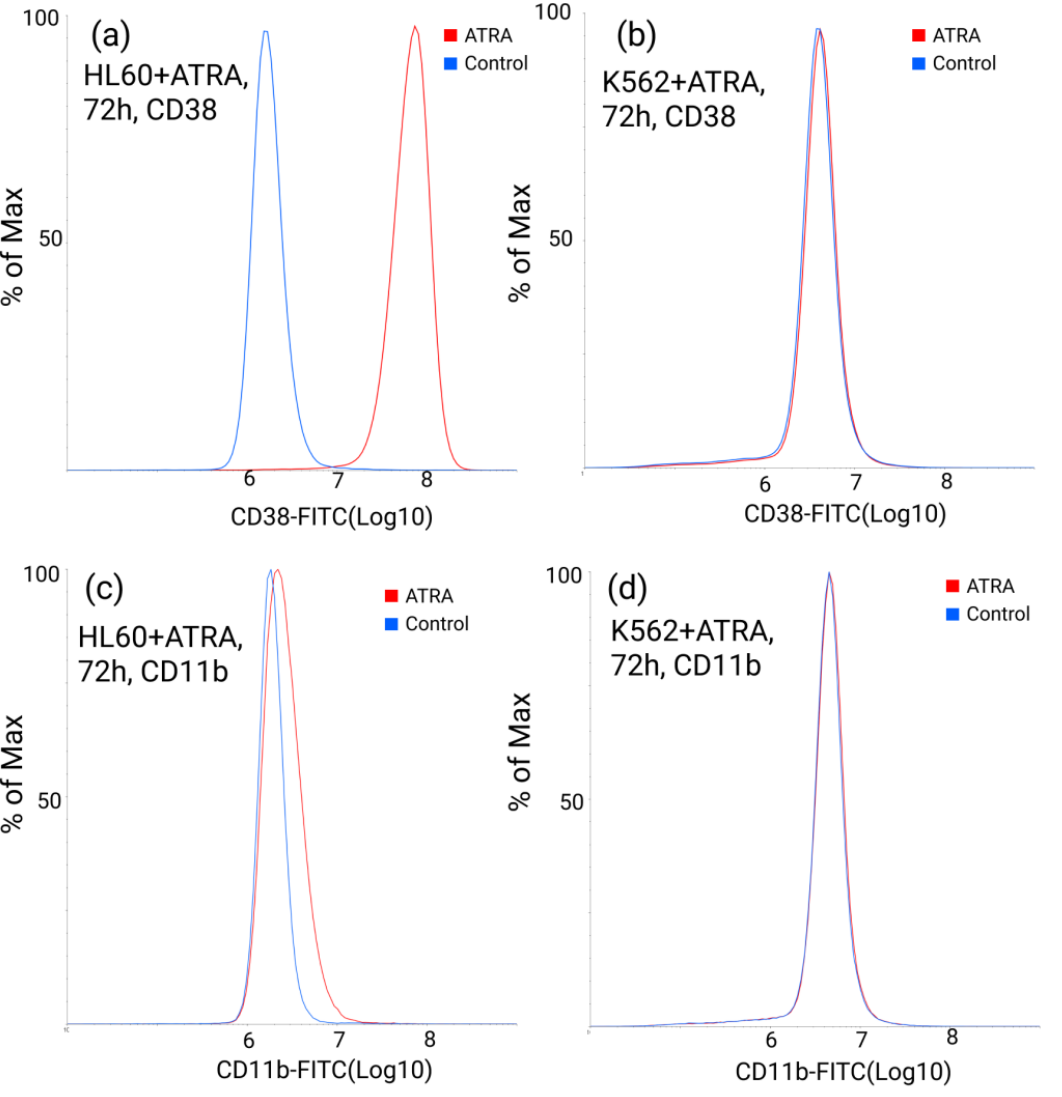
Figure 1. Flow cytometric assessment of the granulocytic marker CD38 surface expression ( a ) in all- trans -retinoid acid (ATRA)-treated HL-60 cells (red), compared to non-treated HL-60 cells (blue), and ( b ) in ATRA-treated K562 cells (red), compared to non-treated K562 cells (blue) at 72 h after the ATRA treatment. Flow cytometric assessment of granulocytic marker CD11b surface expression ( c ) in ATRA-treated HL-60 cells (red), compared to non-treated HL-60 cells (blue), and ( d ) in ATRA-treated K562 cells (red), compared to non-treated K562 cells (blue) at 72 h after the ATRA treatment.